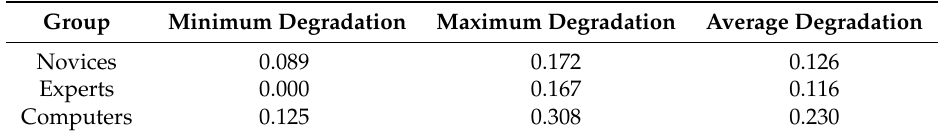
Figure 7. Effect of distortions on the performance of the models. Each data series is the average of two models trained with the given true negative weight λ tn . Table 4. Minimum, maximum, and average degradation of the fraction of images that were successfully classified, from distortion level 0 to 3 for humans and computers.